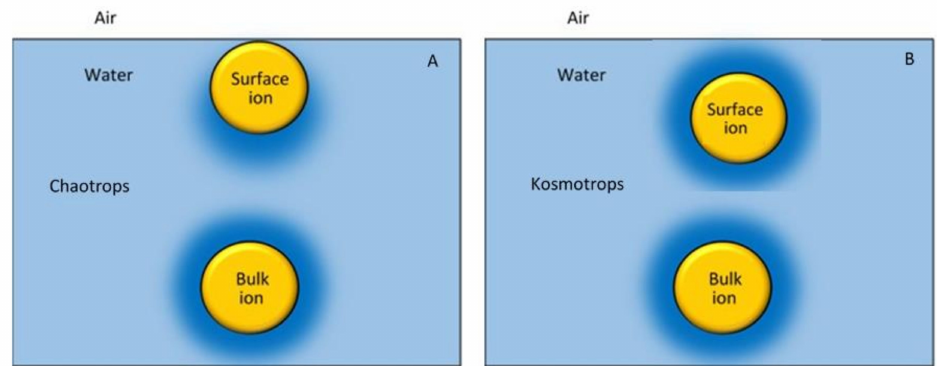
Figure A1. Examples of chaotrops ( A ) and kosmotrops ( B )—the ions that are chaotrops deform their hyddration shells during their adsoprtion, while the ions that are kosmotrops keep their hydration shell undeformed during their adsoprtion.